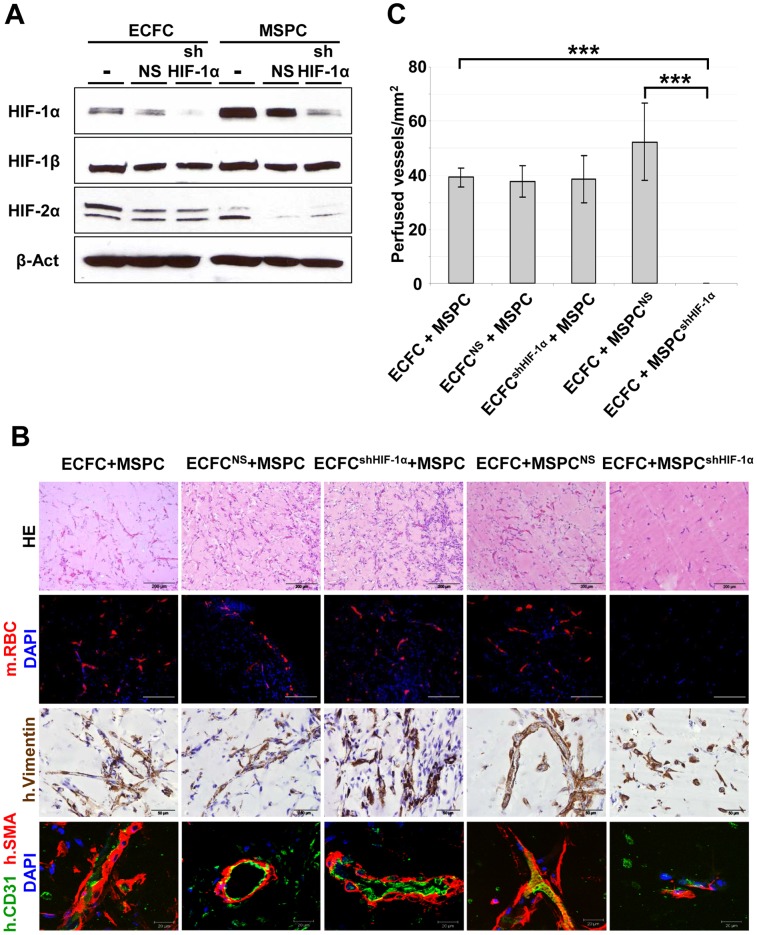
Specific knock-down of HIF-1α in MSPCs but not in ECFCs inhibits vessel formation in vivo.(A) Total cell lysates of untreated control (−) ECFCs and MSPCs or after infection with either pGIPZ-HIF1α-shRNA (shHIF-1α) or non-specific pGIPZ-scramble-shRNA (NS) were separated by SDS-PAGE after 6 hours of incubation at 1% O2. Blots were stained with HIF-1α, HIF-2α, HIF-1β or β-actin (β-Act). Full blots are shown in Figure S2. (B) To delineate the impact of genetic ablation of HIF-1α in either ECFCs or MSPCs before co-transplantation, vessel formation was determined one week after co-transplantation of HIF-1α-silenced (ECFCshHIF-1α, n = 3; MSPCshHIF-1α, n = 7) or mock-transfected non-silenced cells (ECFCNS, n = 3; MSPCNS, n = 7) with genetically un-manipulated corresponding (+ECFC and +MSPC) partner cells as indicated above the columns. Analysis was performed as specified in Figure 3A and is identified at the left side of the picture. Scale bars indicate magnification (first and second row, 200 µm; third row, 50 µm; fourth row, 20 µm). (C) Microvessel density was quantified in 200x magnifications of HE stained Matrigel plug sections by ImageJ counting red blood cell filled vessel structures. A significantly decreased capacity to form perfused vessels was found in implants containing shHIF-1α transfected MSPCs compared to untreated co-transplants. (n = 3, 5 high power fields 200x, mean ± SEM; ***p<0.0001).